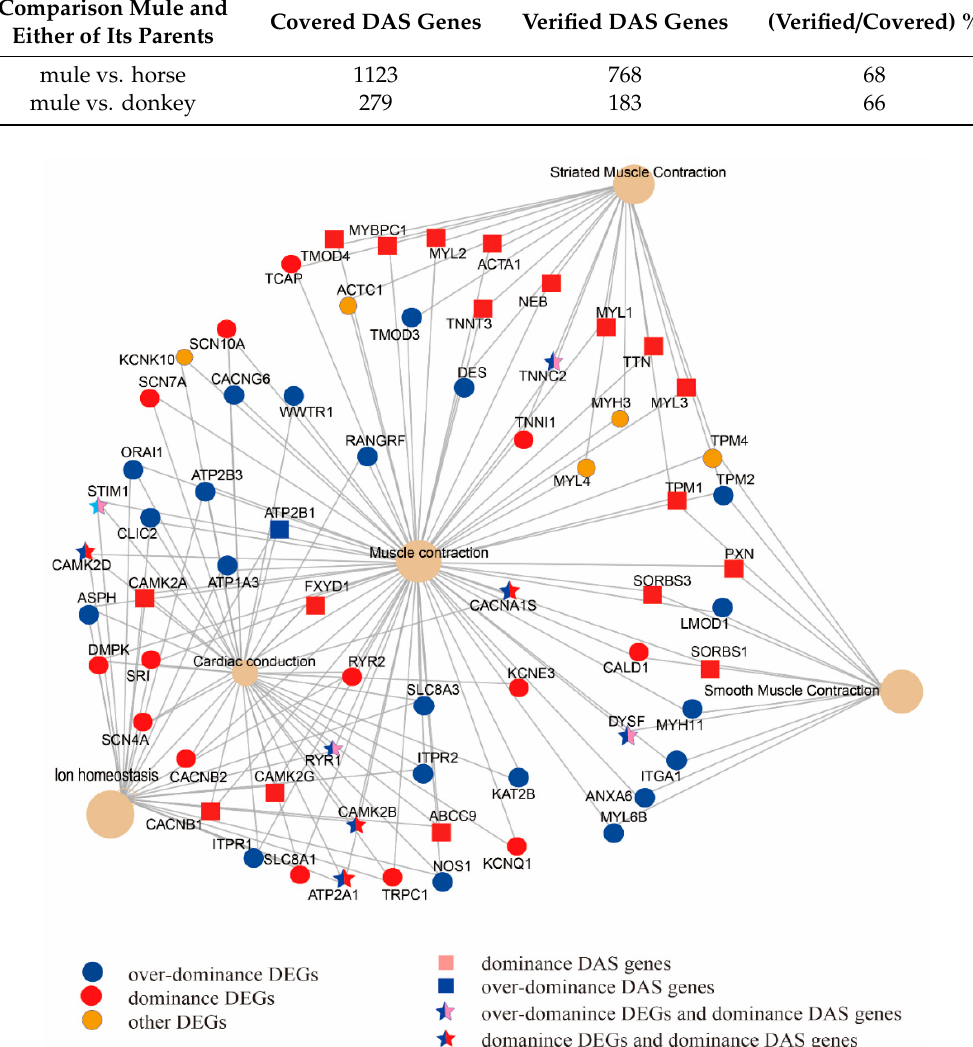
Figure 3. DEGs and genes with DAS events belonging to the models of over-dominance and dominance were enriched in the muscle contraction pathway.